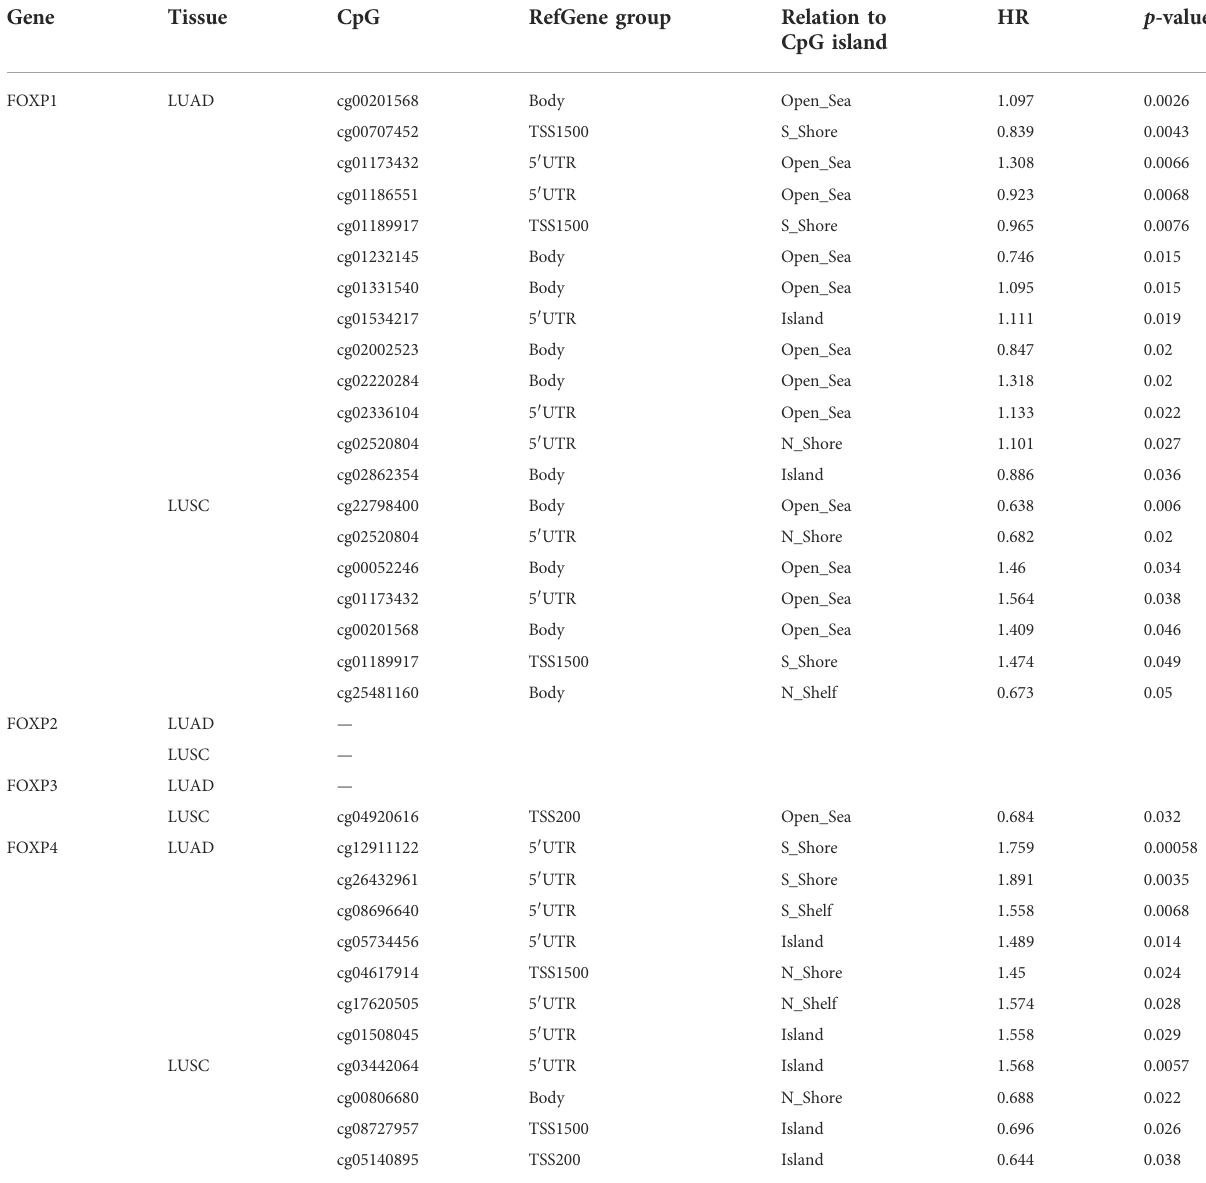
TABLE 1 The prognostic value of single CpG of FOXP family in NSCLC by MethSurv ( p < 0.05). Gene Tissue CpG RefGene